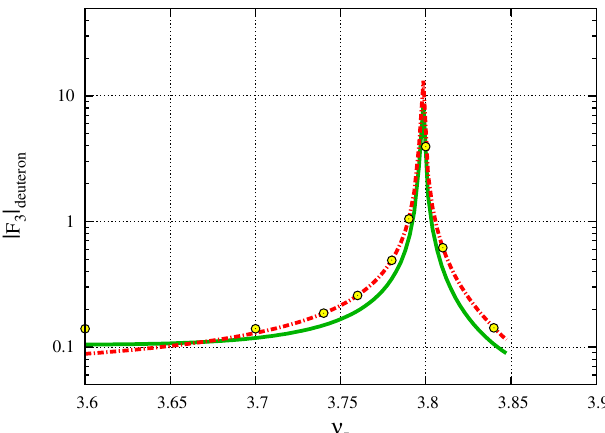
FIG. 3. Graph of j F 3 j (for protons, at the location of the rf dipole in COSY) plotted against the vertical betatron tune (cid:5) The proton momentum is p ¼ 2 : 1 GeV =c . The solid curve is a numerical calculation. The dot-dashed curve is (a factor of 2 times) the experimental fit to the data, published by the authors of